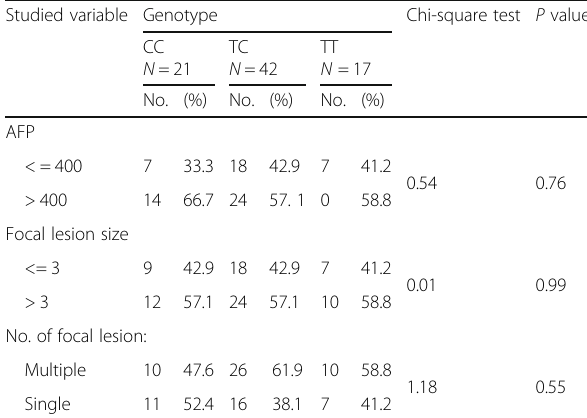
Table 8 Relation between the different genotypes and the aggressiveness of HCC (size and number of focal lesions and AFP level) among HCC